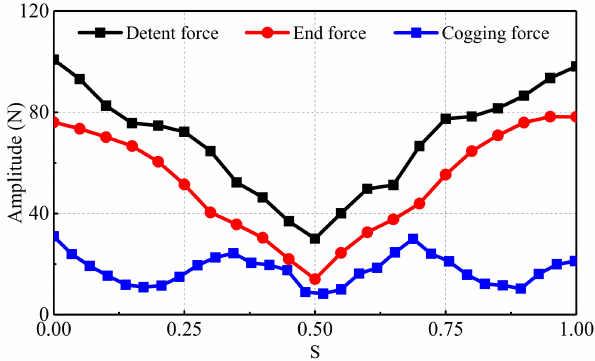
Figure 12. End force, cogging force, and detent force vary with S